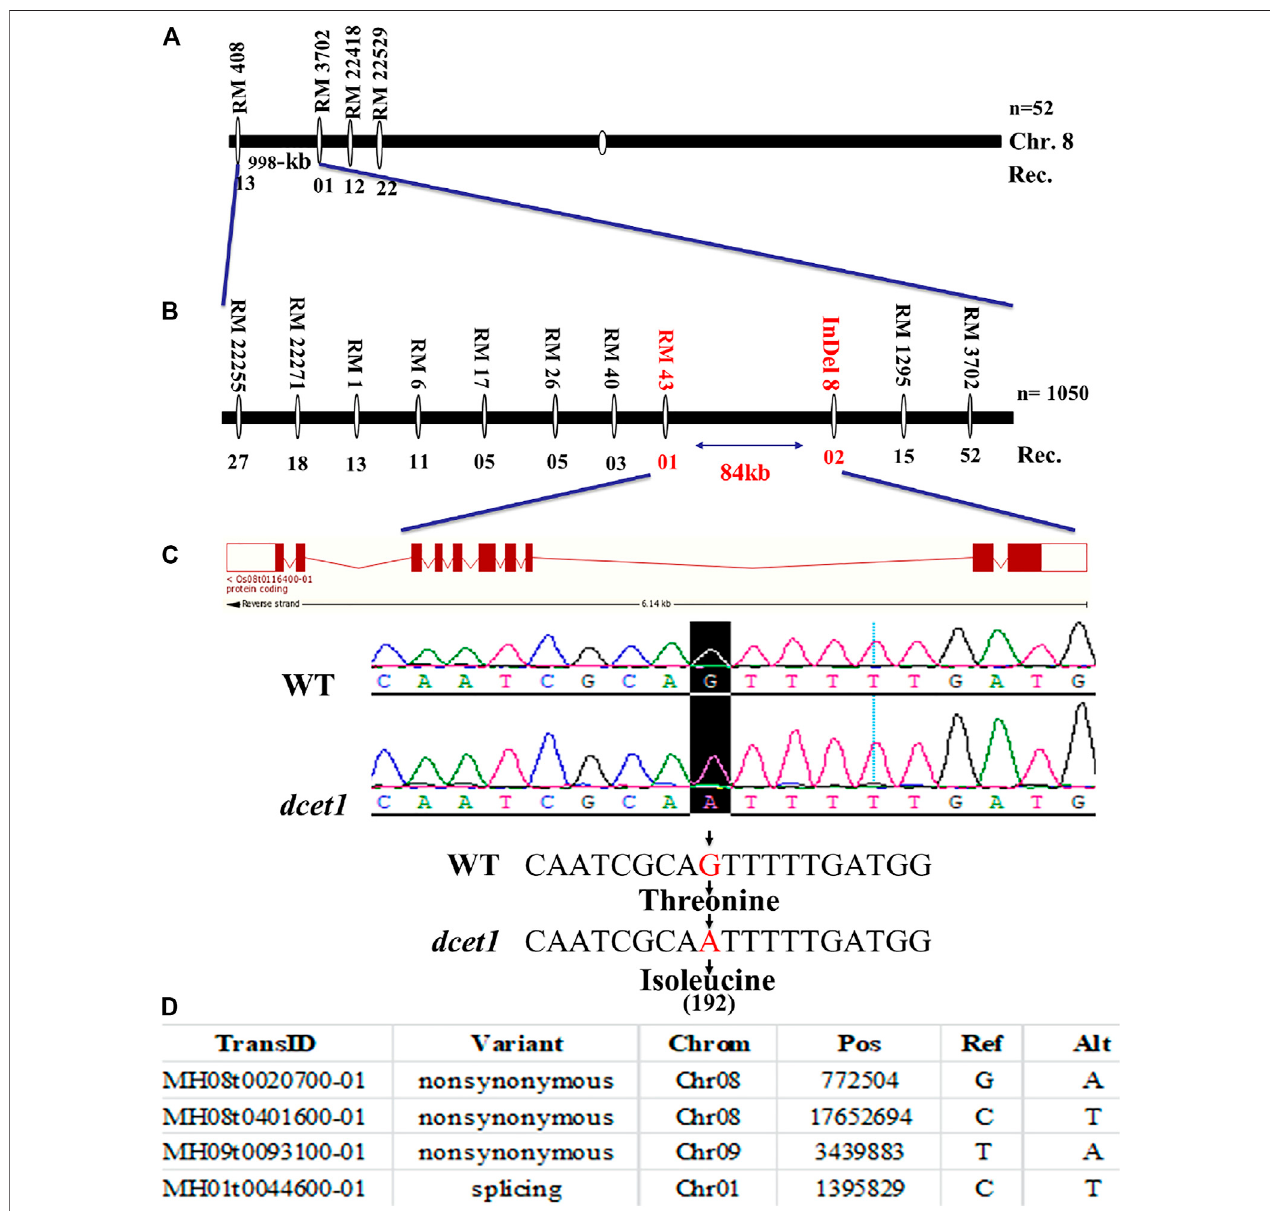
FIGURE 9 | Representation of map-based cloning of the DCET1 gene and MutMap candidate all index SNP genes. Primary mapping (A) . Fine mapping (B) . Structureofthe DCET1 gene and single-nucleotide substitutioninmutant dcet1 fromG(threonine) toA(isoleucine)on 192aminoacids (C) .MutMap candidate Allindex SNP genes (D)